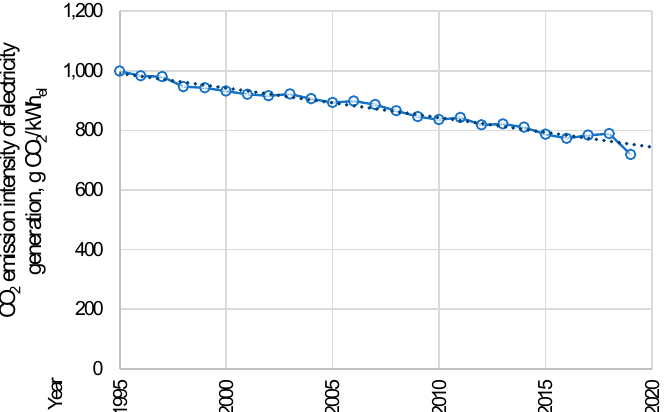
Figure 5. Variability of CO 2 emission intensity of electricity production EI E in 1995–2019 (own study based on data [10]).